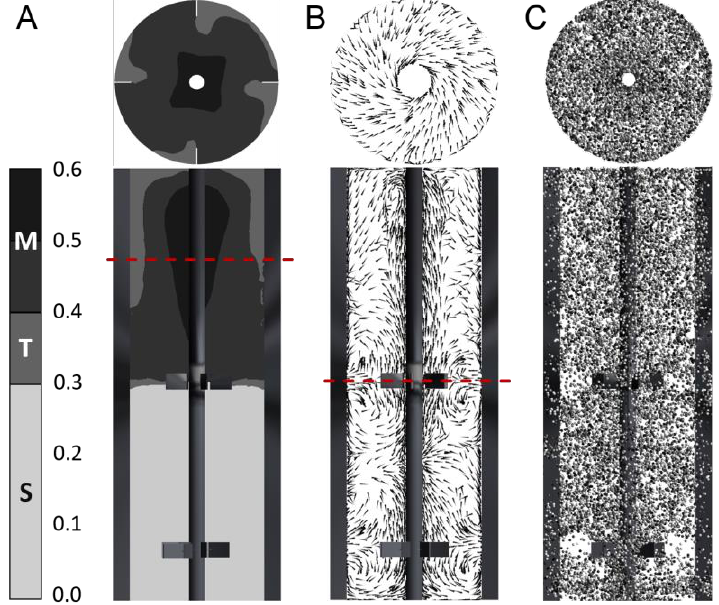
Figure 2. Simulation of gradients and bacterial lifelines. ( A ) Averaged substrate gradient calculated for 150 s, colored by regime classification: standard replication S ( μ < 0.3) in light gray, transition regime T (0.3 ≤ μ ≤ 0.4) in gray, and multifork replication M ( μ > 0.4) in dark gray. ( B ) Average flow field estimated for 150 s. ( C ) Representative magnified bacteria particles (around 2000) at a certain time step (colored by particle ID; low numbers in dark gray represent a starting point close to the reactor bottom, high numbers in light gray represent a starting point close to the reactor top). Horizontal section planes are indicated by dashed red lines; otherwise, the top view is shown.